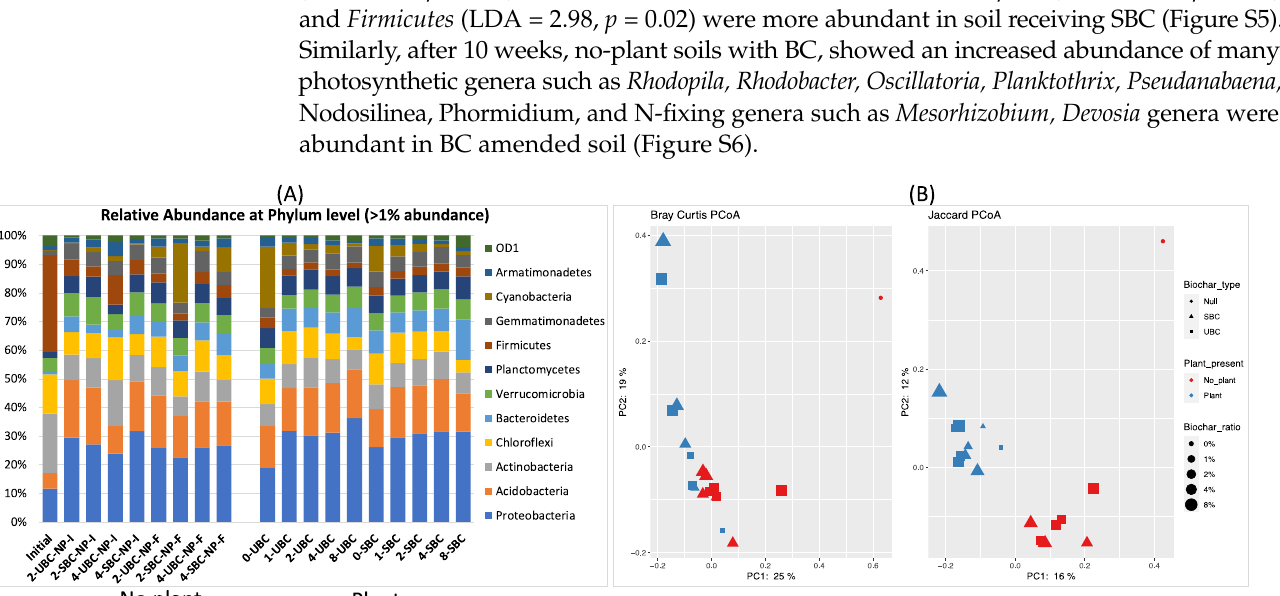
Figure 5. Microbial community composition. Relative abundance of major taxa at phylum level ( A ). Principal coordinate analysis of the microbial community at OUT level ( B ). (Abbreviations: NP; No plant, I; Initial, F; Final) .